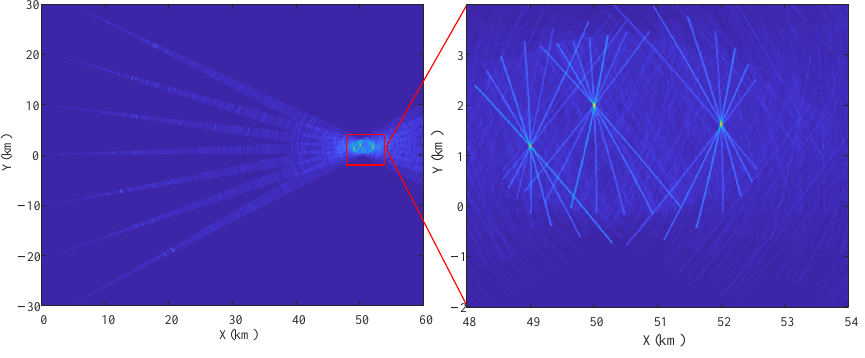
Figure 2. Energy accumulation in